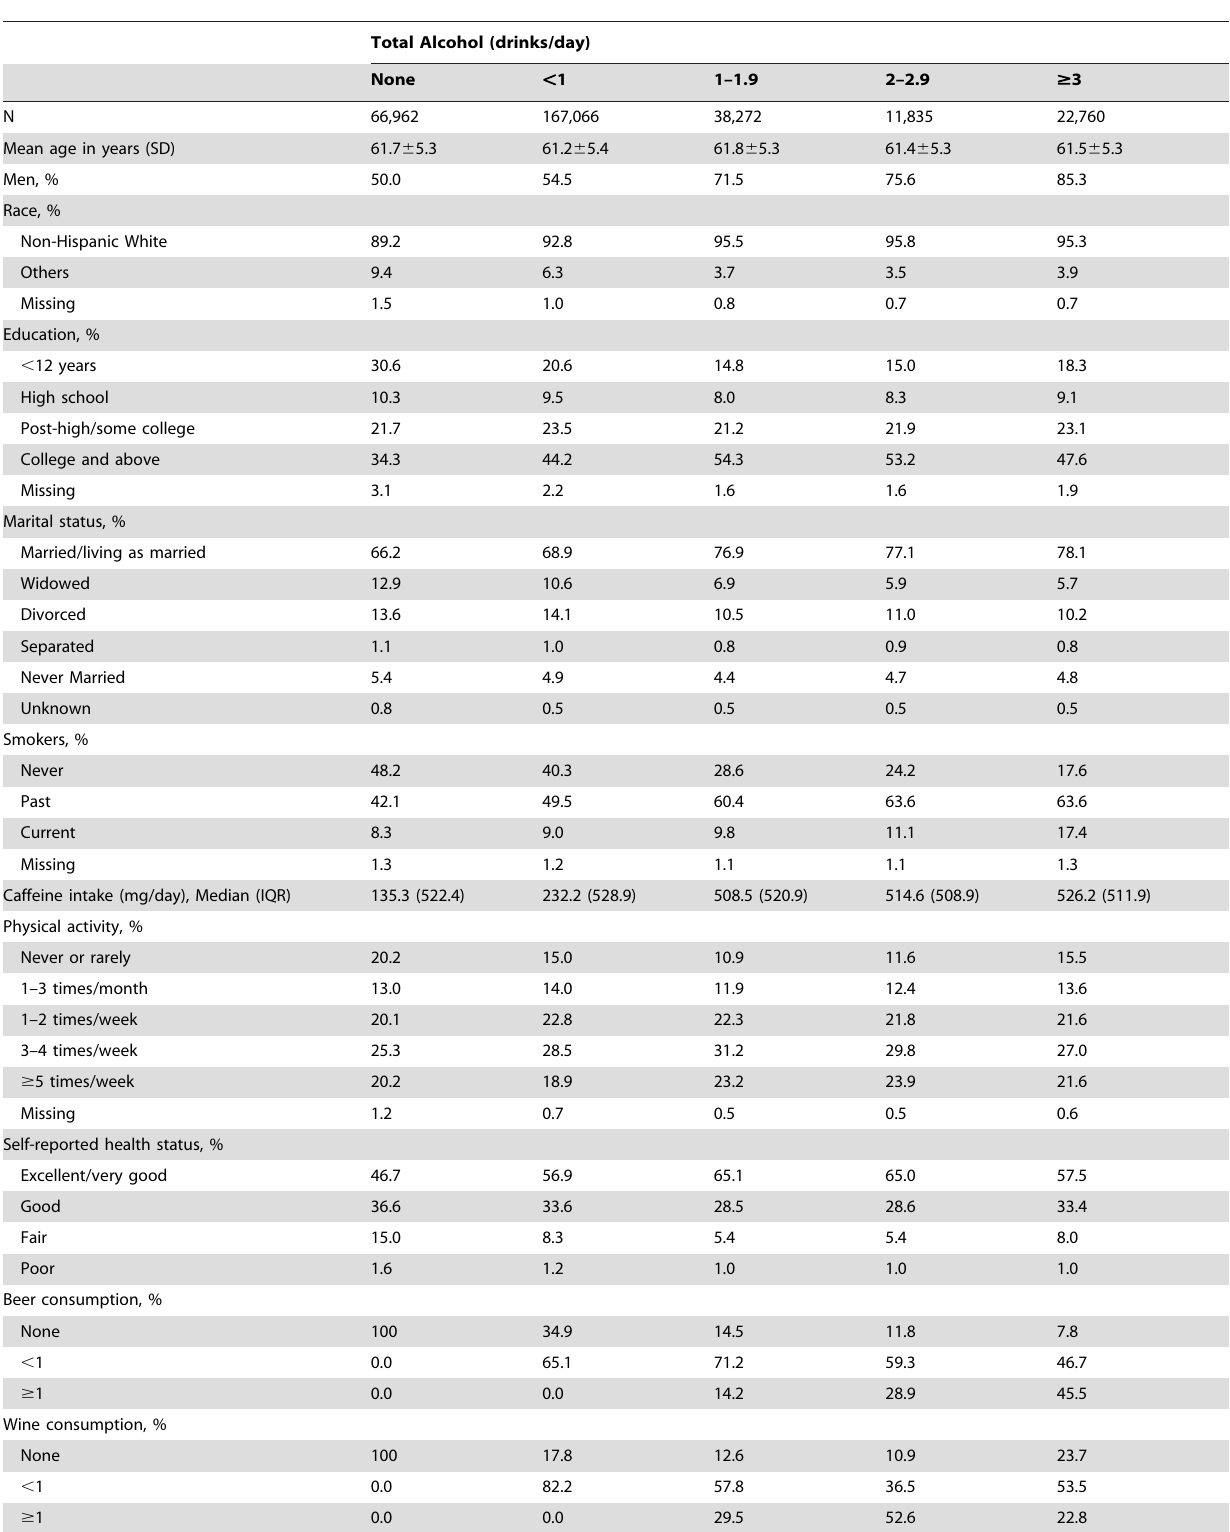
Table 1. Baseline Population Characteristics According to Total Alcohol Consumption Categories, NIH-AARP Diet and Health Study,